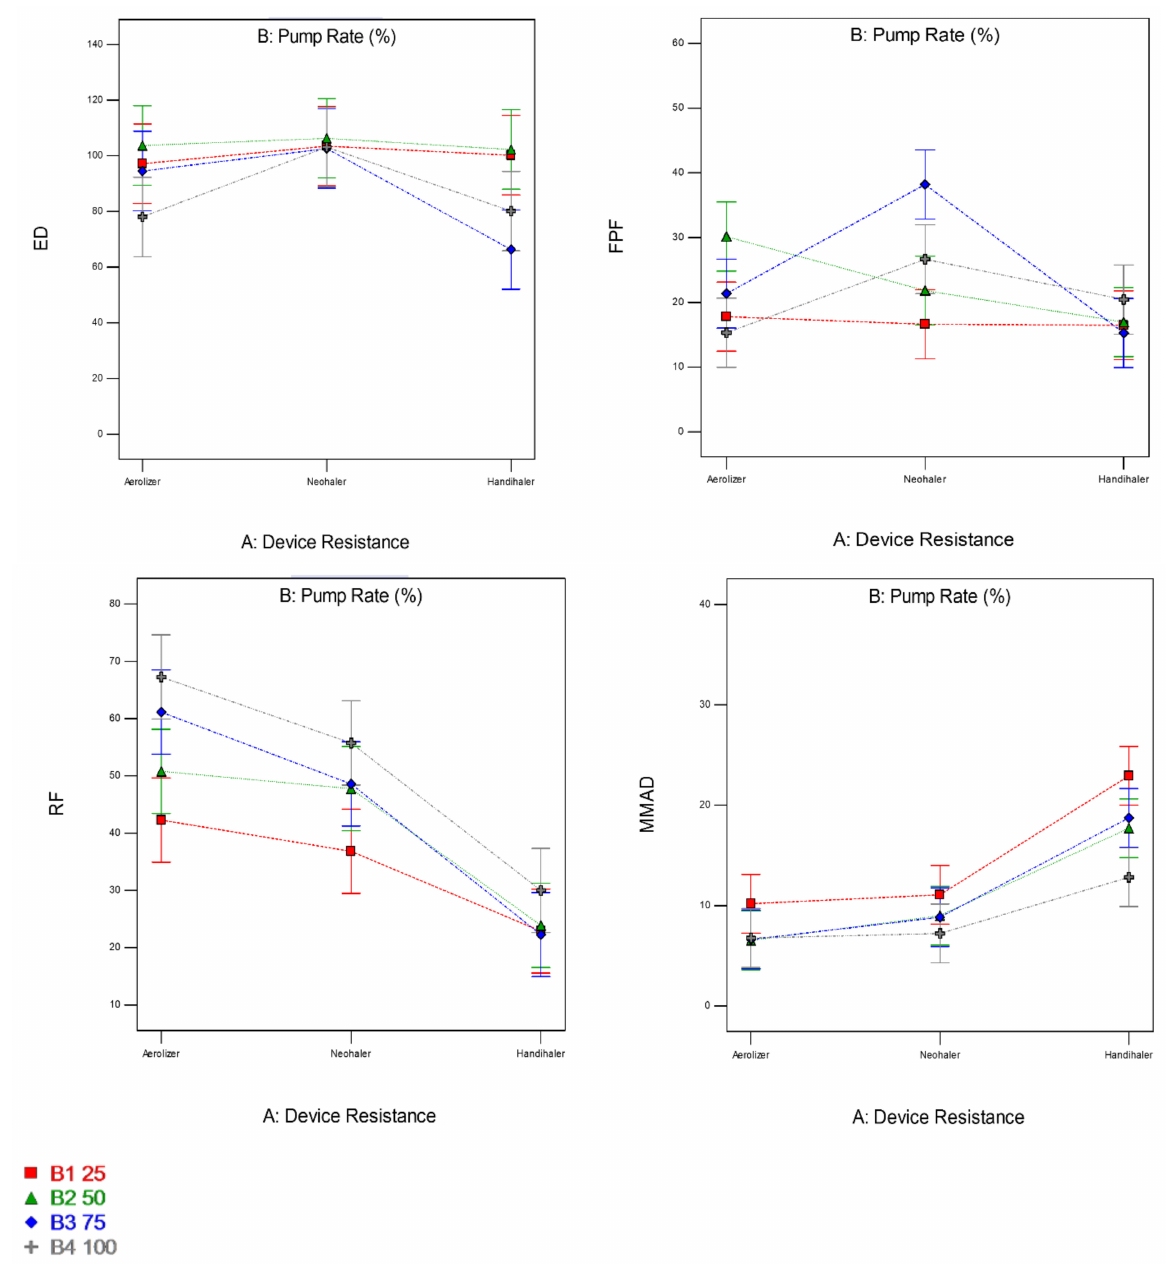
Figure 12. Design of experiments (DOEs) interaction plots (Design Expert ® 8.0.7.1 software, Stat-Ease Corporation, Minneapolis, MN, USA) of spray drying pump rate and inhaler device resistance on in vitro aerosol performance parameters for all 4 SD FAS dry powders (25% PR, 50% PR, 75% PR, and 100%